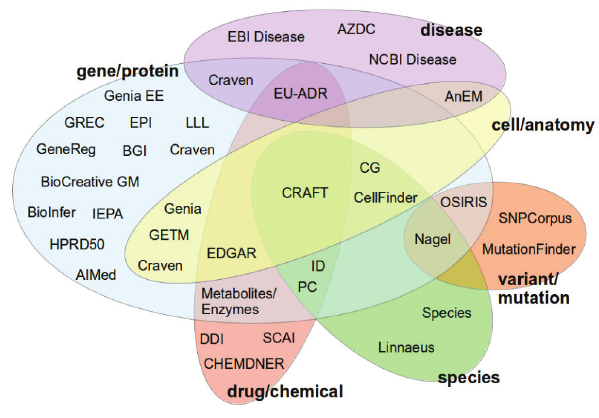
Figure 1. Classification of the corpora according to the semantic annotations they